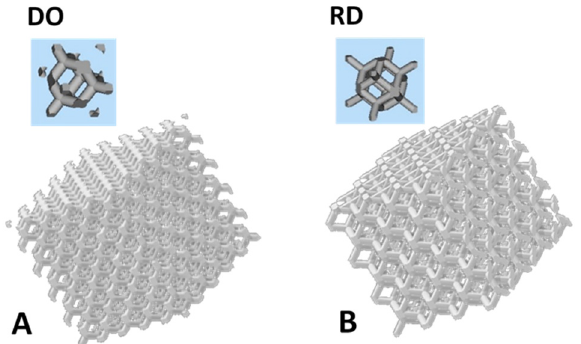
Figure 1. Schematics of the scaffolds’ elementary unit cell geometry: ( A ) diamond (DO) and ( B ) rhombic dodecahedron (RD).